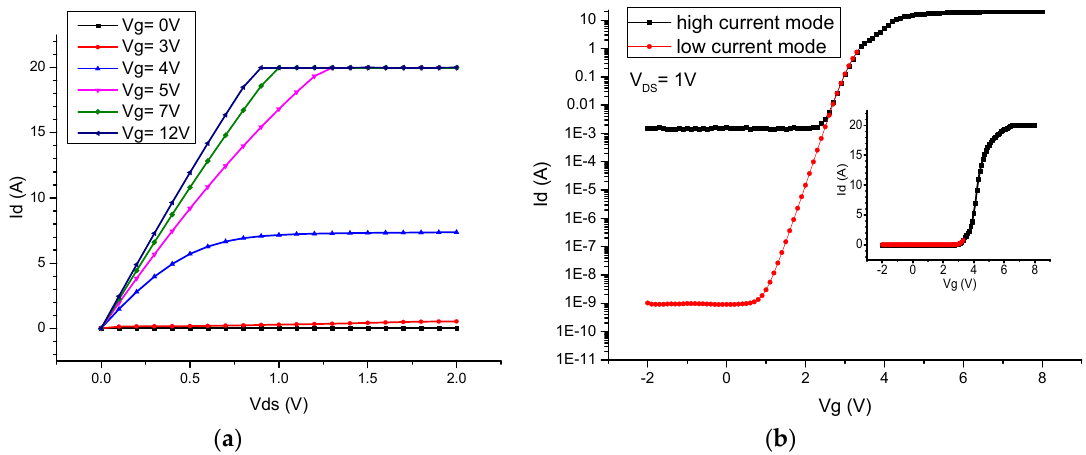
Figure 3. ( a ) Output curves and ( b ) transfer curves for the fabricated devices.